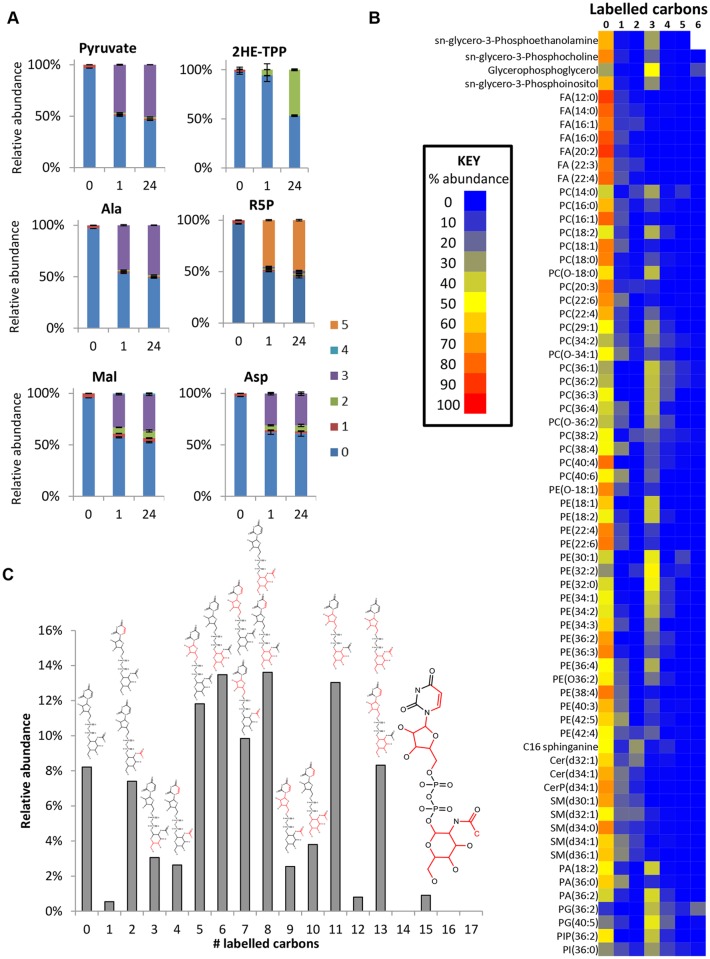
Glucose is a carbon source for acetate, lipids and sugar nucleotides in WT BSF T. brucei.(A) Time-dependent incorporation of glucose into diverse pathways. Relative isotopologue abundances for unlabelled cells (0) and cells incubated with 50% U-13C-glucose in HMI11 for one hour (1) and 24 hours (24). Labelling reaches equilibrium within 1 hour for pyruvate, alanine, malate, aspartate and ribose 5-phosphate. Minimal labelling is observed in 2-hydroxyethyl-TPP after 1 hour, but complete (50%) labelling occurs within 24 hours, indicating a relatively slow flux towards acetate production by this pathway. (n = 3, mean ± SD). (B) Heatmap of relative isotopologue abundances for lipids after labelling for 24 hours with 50% U-13C-glucose in HMI11 indicating a combination of salvage mechanisms with de novo synthesized glycerol phosphate and limited incorporation of glucose-derived acetyl-CoA. After manual curation, no isotopologues containing more than 6 labelled carbons could be confirmed for the detected lipids. (C) Isotopologue abundances of UDP-N-acetyl glucosamine (UDP-GlcNAc) after labelling for 24 hours with 50% U-13C-glucose in HMI11 reveal incorporation of labelled carbon through glucosamine, acetate, ribose and uracil. Structures represent the likely isotopologue(s) for each mass with 13C atoms and bonds shown in red. Additional minor isotopologues have been omitted for clarity, the most abundant of which are isotopologues containing 3-labelled glucosamine 6-phosphate.